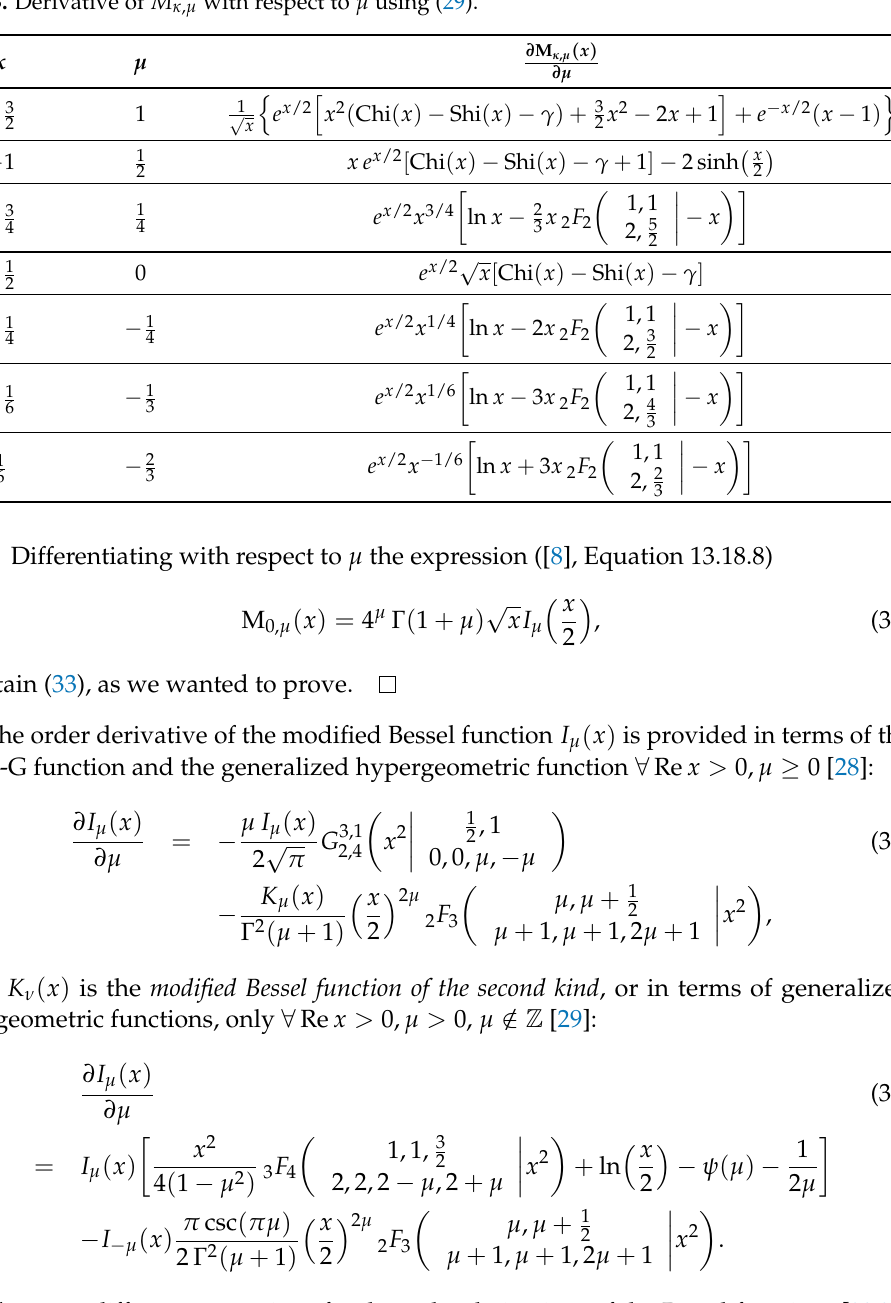
Table 3. Derivative of M κ , µ with respect to µ using